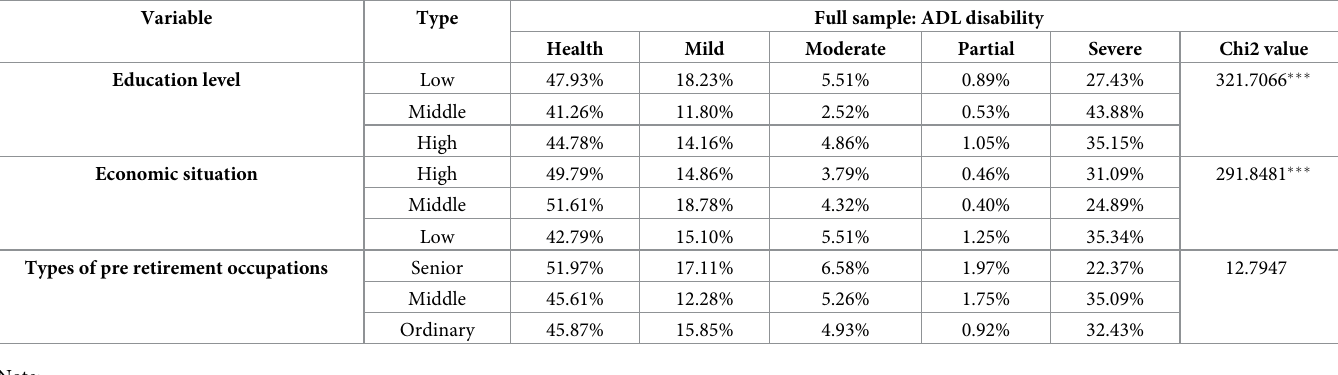
Table 2. SES and ADL disability of the older